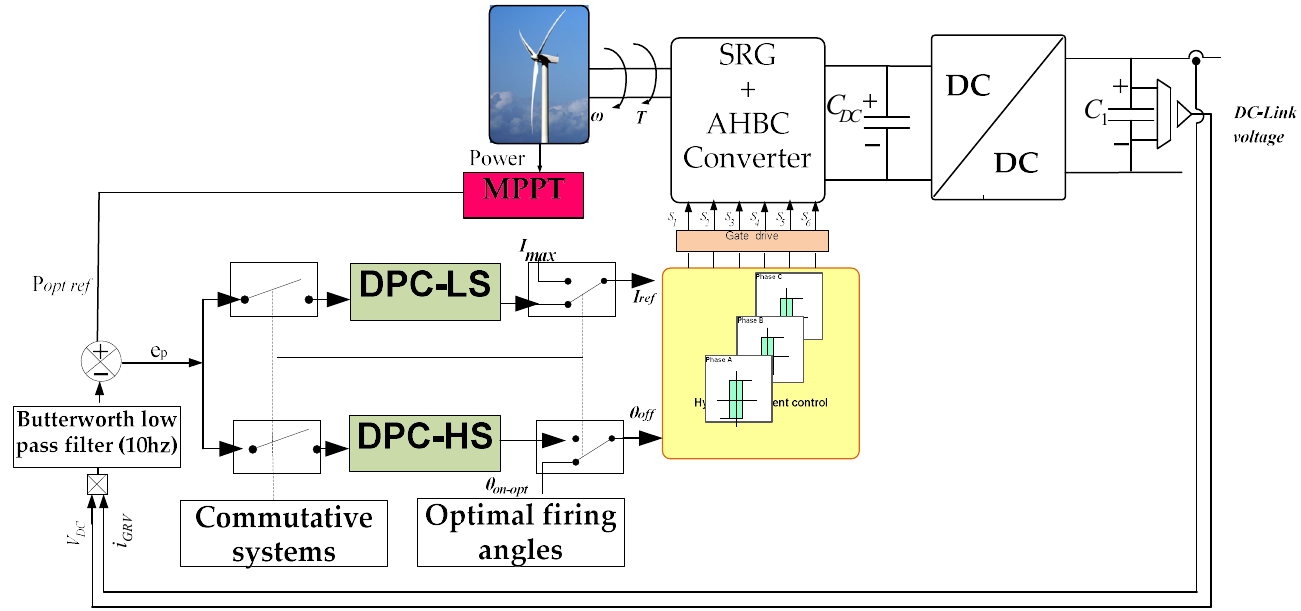
Figure 15. Schematic diagram of direct power control.